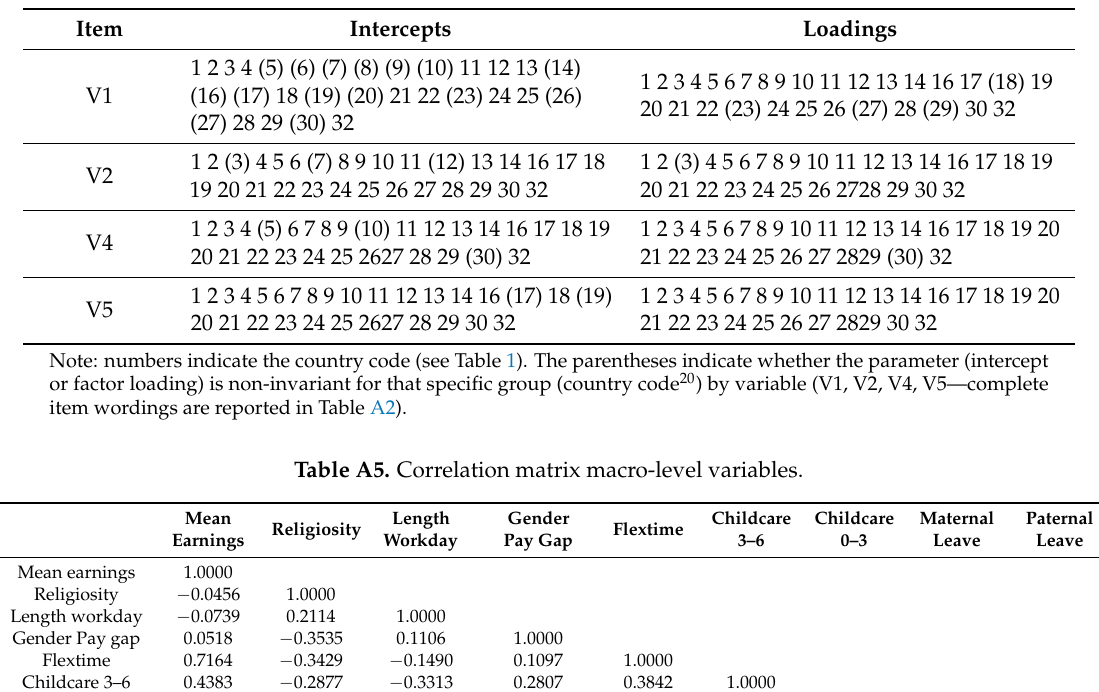
Table A4. Alignment results. Approximate measurement (non) invariance for intercepts and loadings of the 4-item model (12% non-invariant parameters).